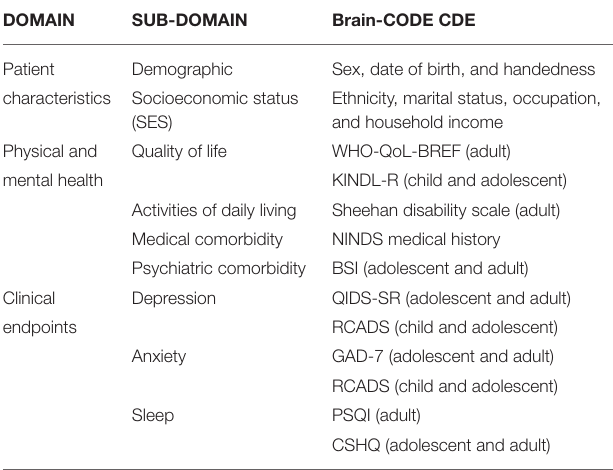
TABLE 1 | Brain-CODE demographic and clinical